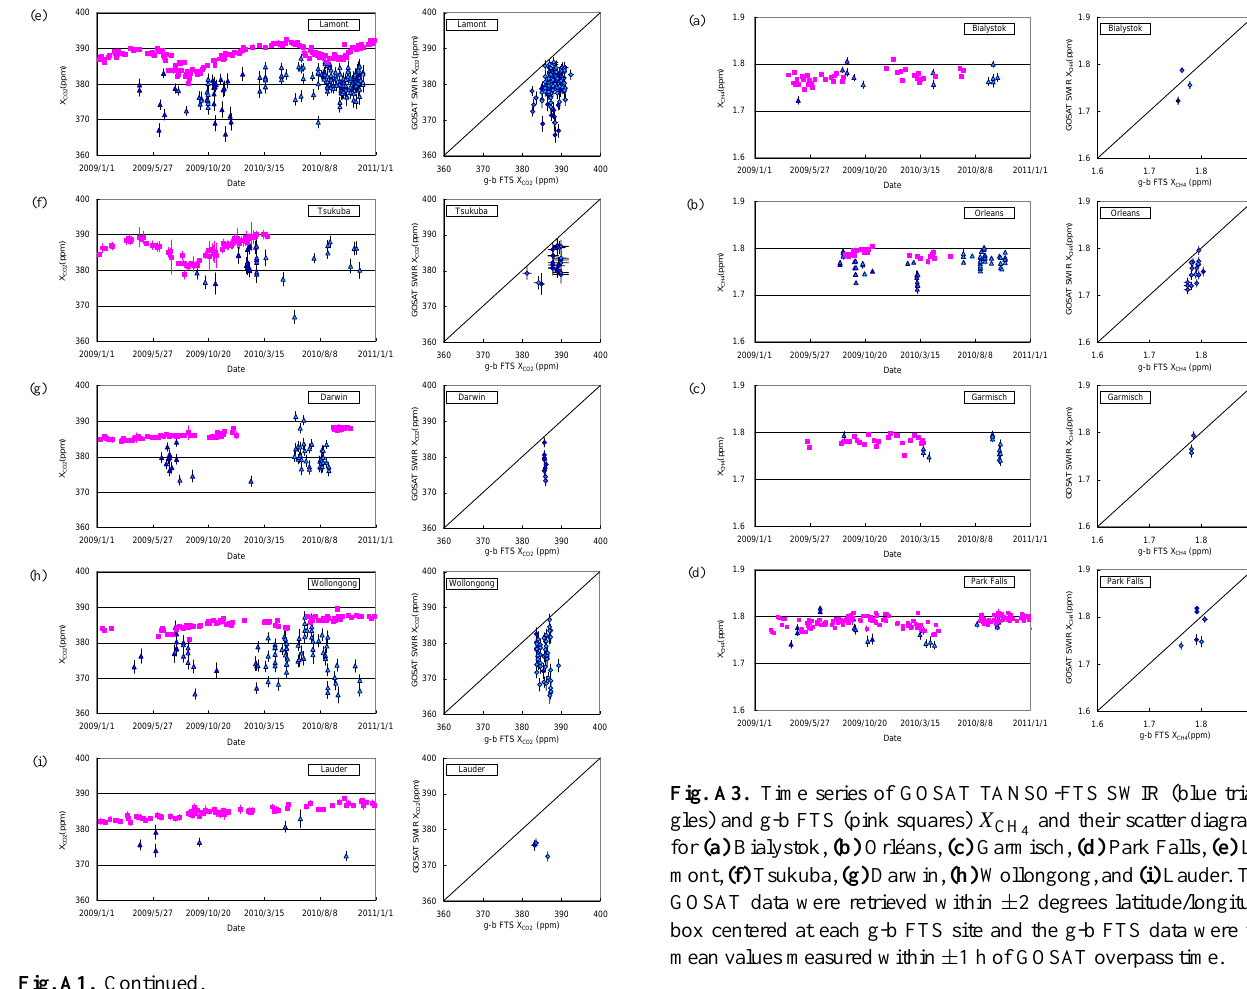
Fig.A2. 6 Fig. A1. Continued.